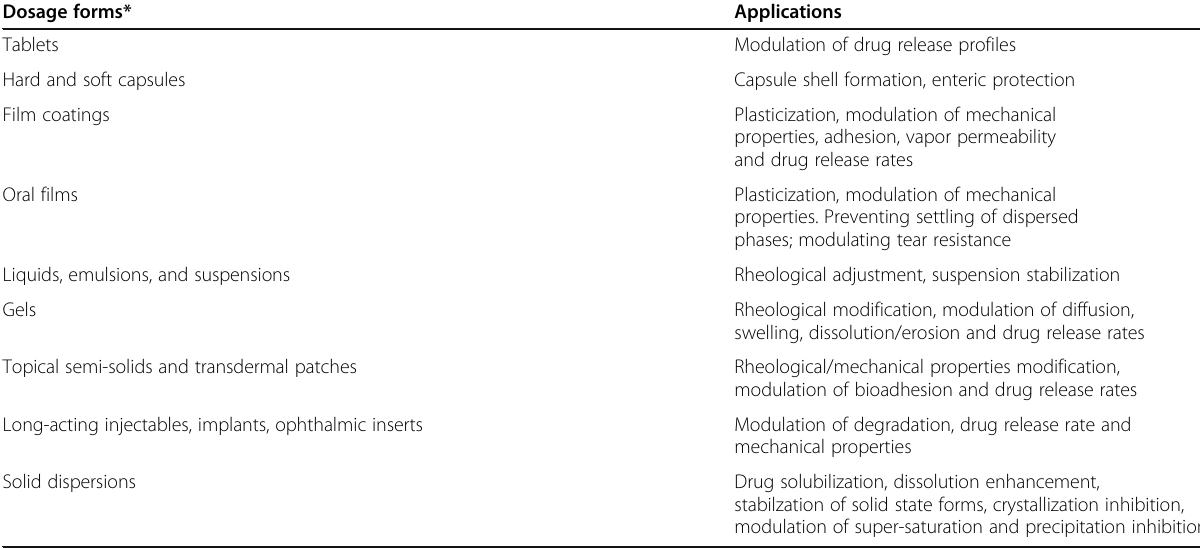
Table 1 Pharmaceutical applications of polymer